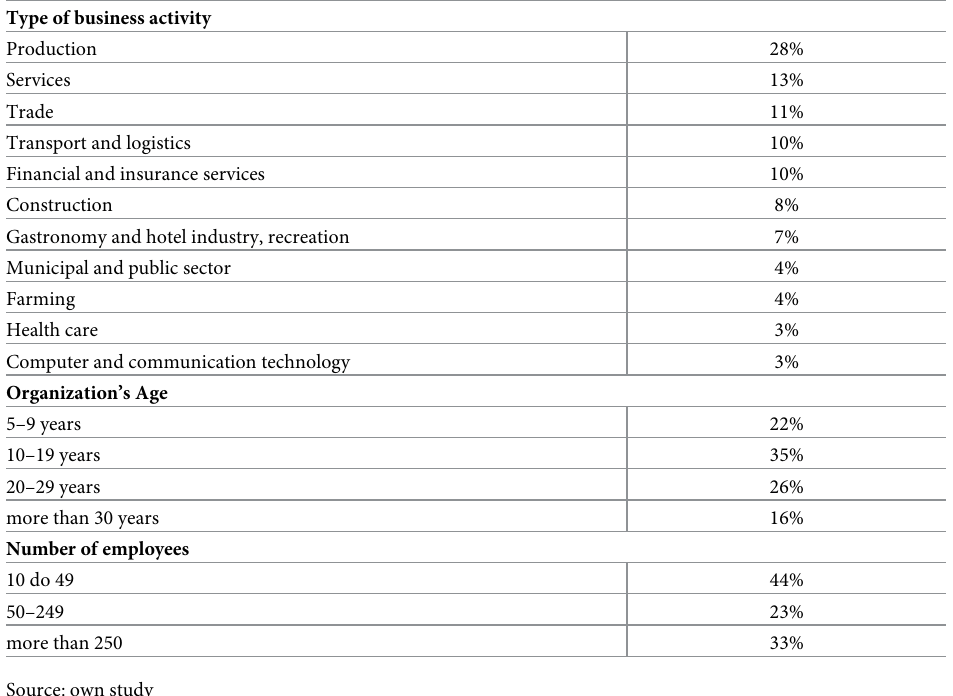
Table 2. Characteristics of the surveyed enterprises (n =